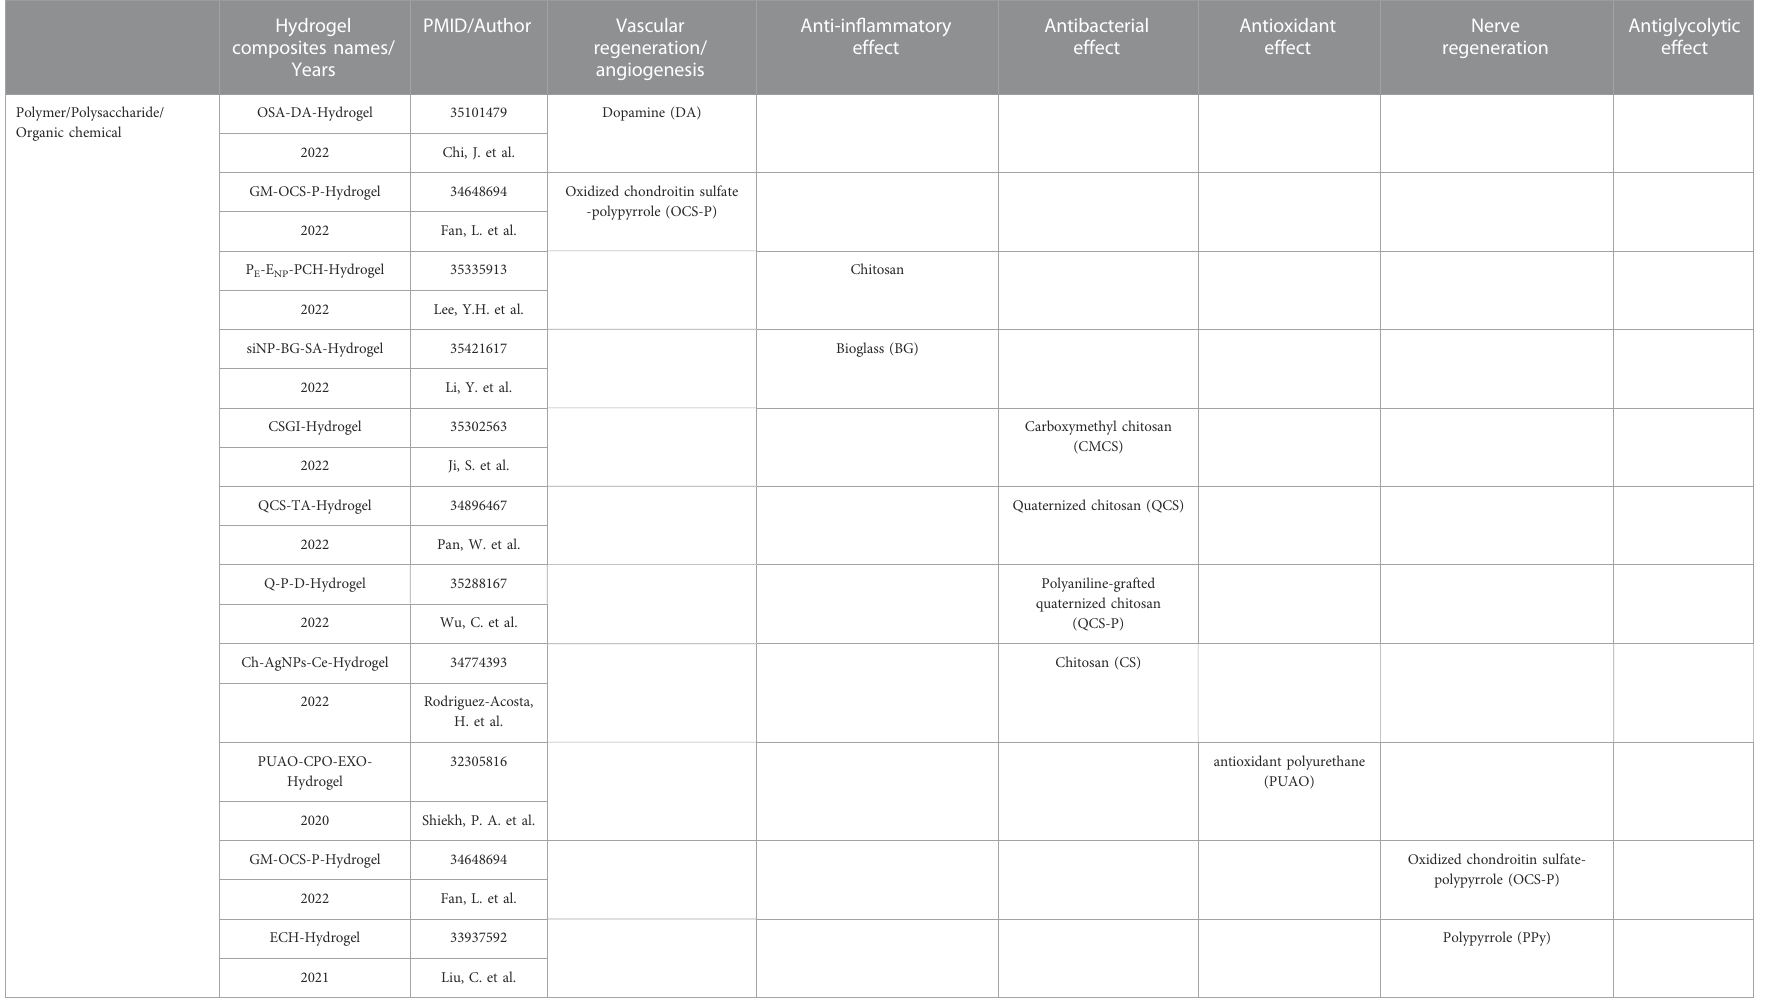
TABLE 1 Classi fi cation of loading components in composite hydrogels in the treatment of chronic diabetic ulcers.